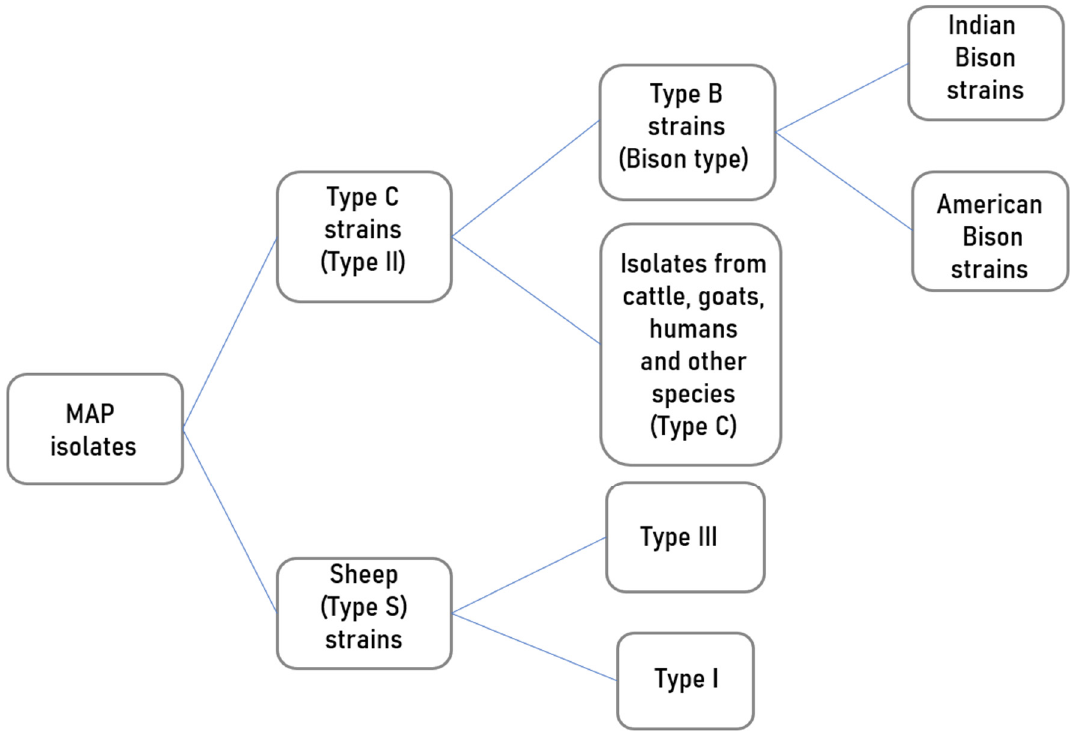
Figure 1. An illustration of MAP strain differentiation based on whole genome SNP-based phylogenetic analysis [13] .